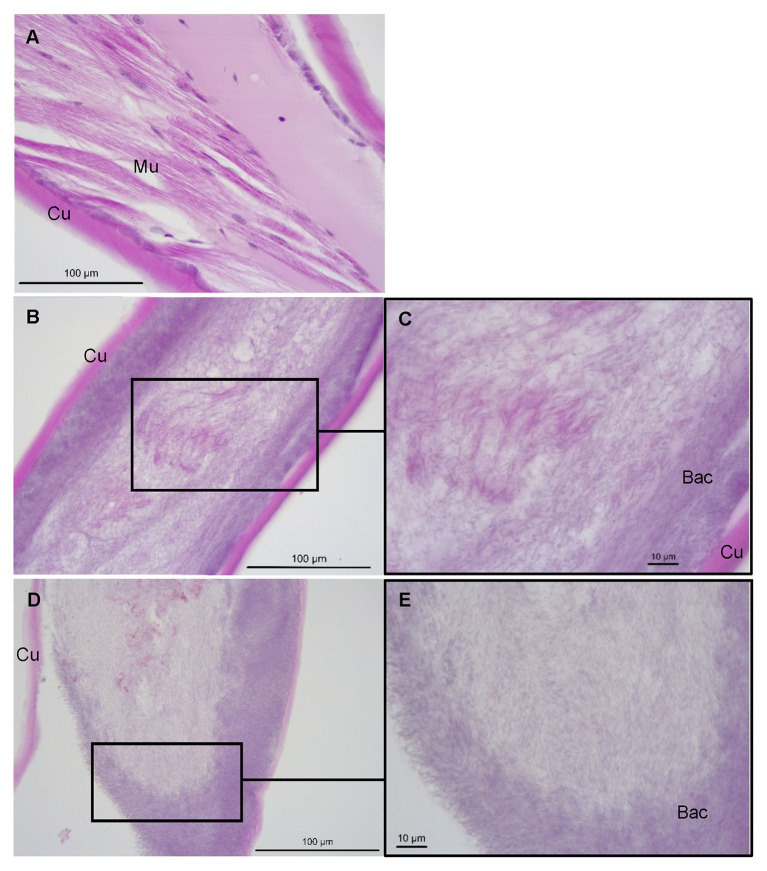
Sagittal sections of P. ornatus pereiopod muscle (Mu) and cuticular (Cu) architecture from (A) control phyllosomas and (B–E) phyllosomas exhibiting lesions following exposure to Aquimarina sp. TRL1. Bac: bacterial colonies. Sections were stained with haematoxylin and eosin.